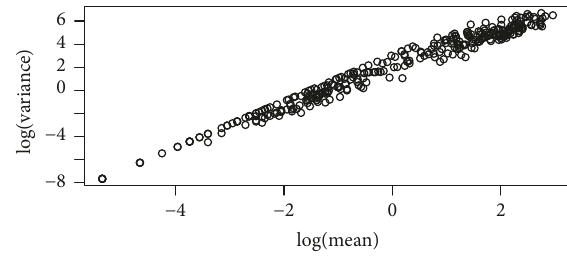
Figure 2: Variance mean